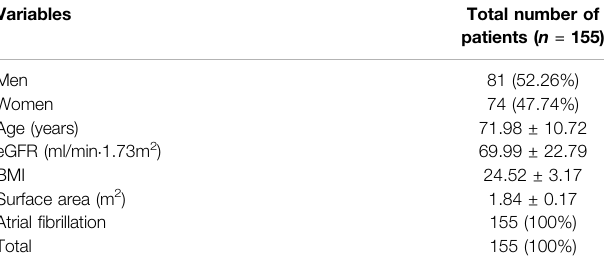
TABLE 2 | Allelic and genotypic frequencies of ABCB1 ( n (cid:1) 155). patients ( n = 155)